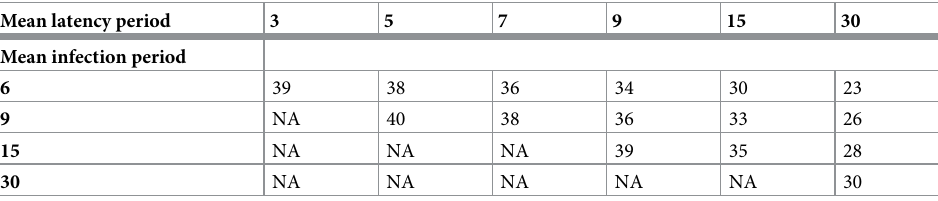
NA NA NA NA 30 The table shows the number of days by which D ratio lags(detects earlier) daily new cases in predicting the wave when all other model parameters are kept constant. The columns represent the mean latency period and the rows represent the mean infection period. It is seen that D ratio consistently performs better than daily new cases in the range of latency and infection periods. The cells with NA represent cases when daily new cases failed to predict a